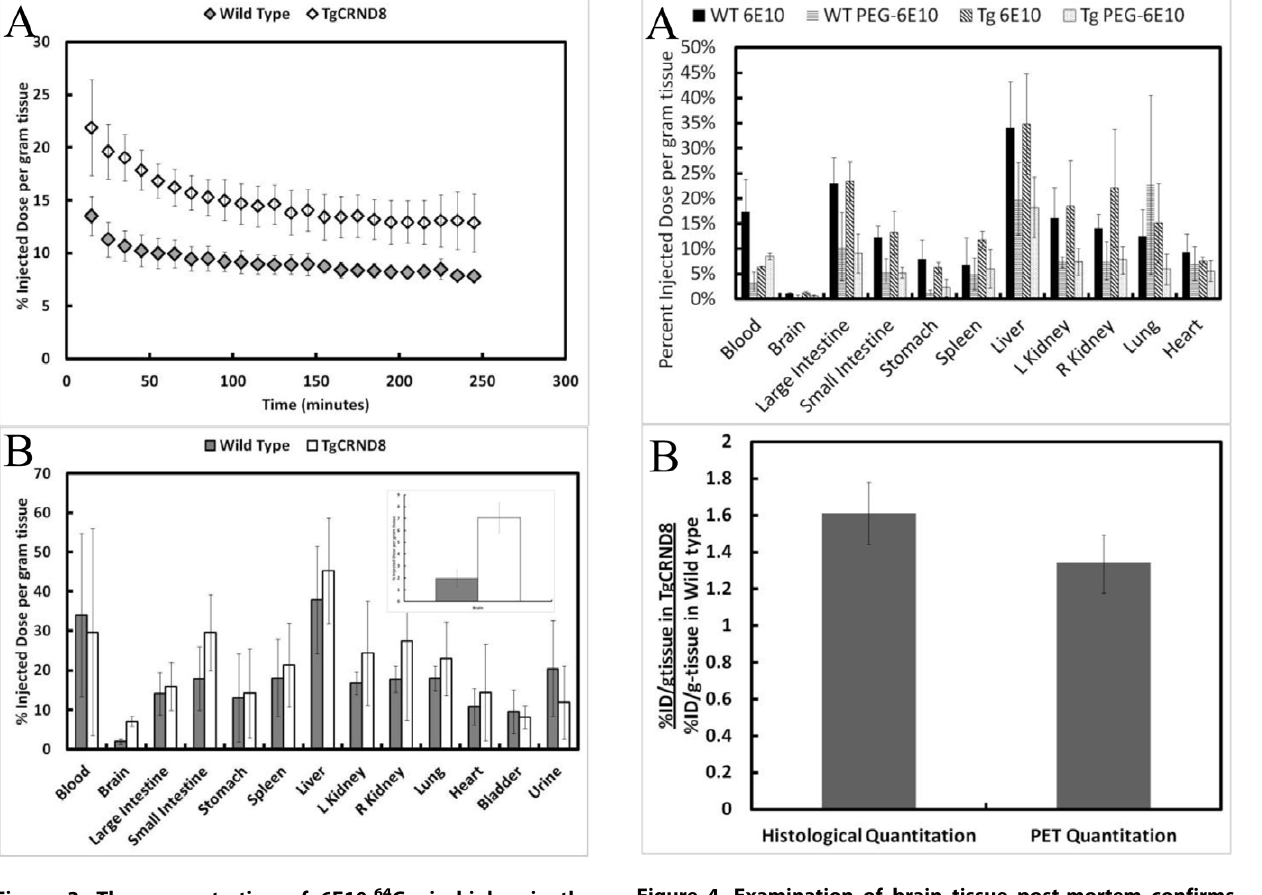
Figure 3. The concentration of 6E10- 64 Cu is higher in the TgCRND8 brain when compared to a wild type control animal after hyperosmotic disruption of the blood-brain barrier. (A) TgCRND8 and wild type mice are dynamically scanned by PET for 4 h after hypersosmotic disruption of the blood-brain barrier and admin- istration of 6E10- 64 Cu. 6E10 levels are consistently higher in the TgCRND8 mouse when compared to the wild type mouse. Two factor ANOVA reveals a significant difference between the TgCRND8 and wild type mice (p , 0.001, n=4, mean 6 standard deviation plotted). (B) Post-mortem biodistribution analysis of the organs shows similar distribution of 6E10 in all organs, except the brain. Increased accumulation in the TgCRND8 brain compared to a wild type brain is shown in the inset panel (n=4, mean 6 standard deviation plotted).